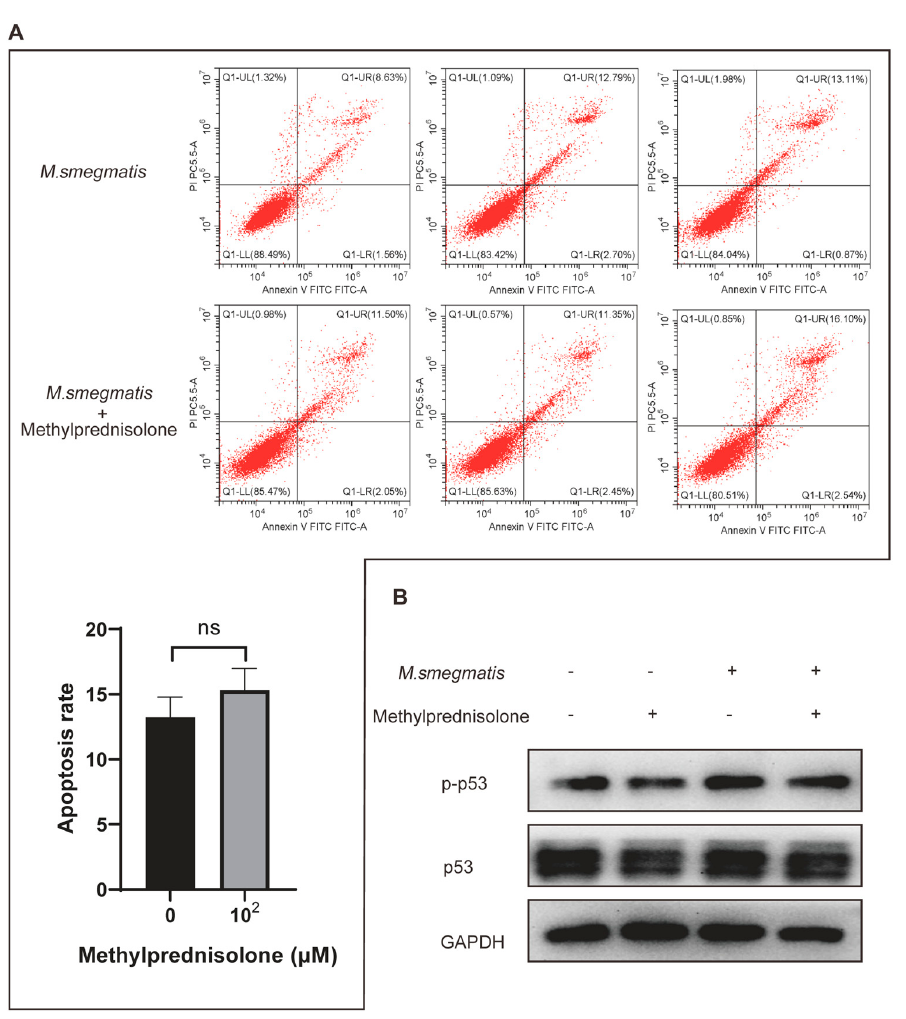
Figure 3. Methylprednisolone (10 2 µ M) treated M. smegmatis infected RAW264.7 cells for 48 h; ( A ) apoptotic cells were detected by flow cytometry; the t-test was used for data analysis; ns no statistical differences. ( B ) Apoptosis-related protein p53 and p-p53 level were detected with Western blot anal- ysis.